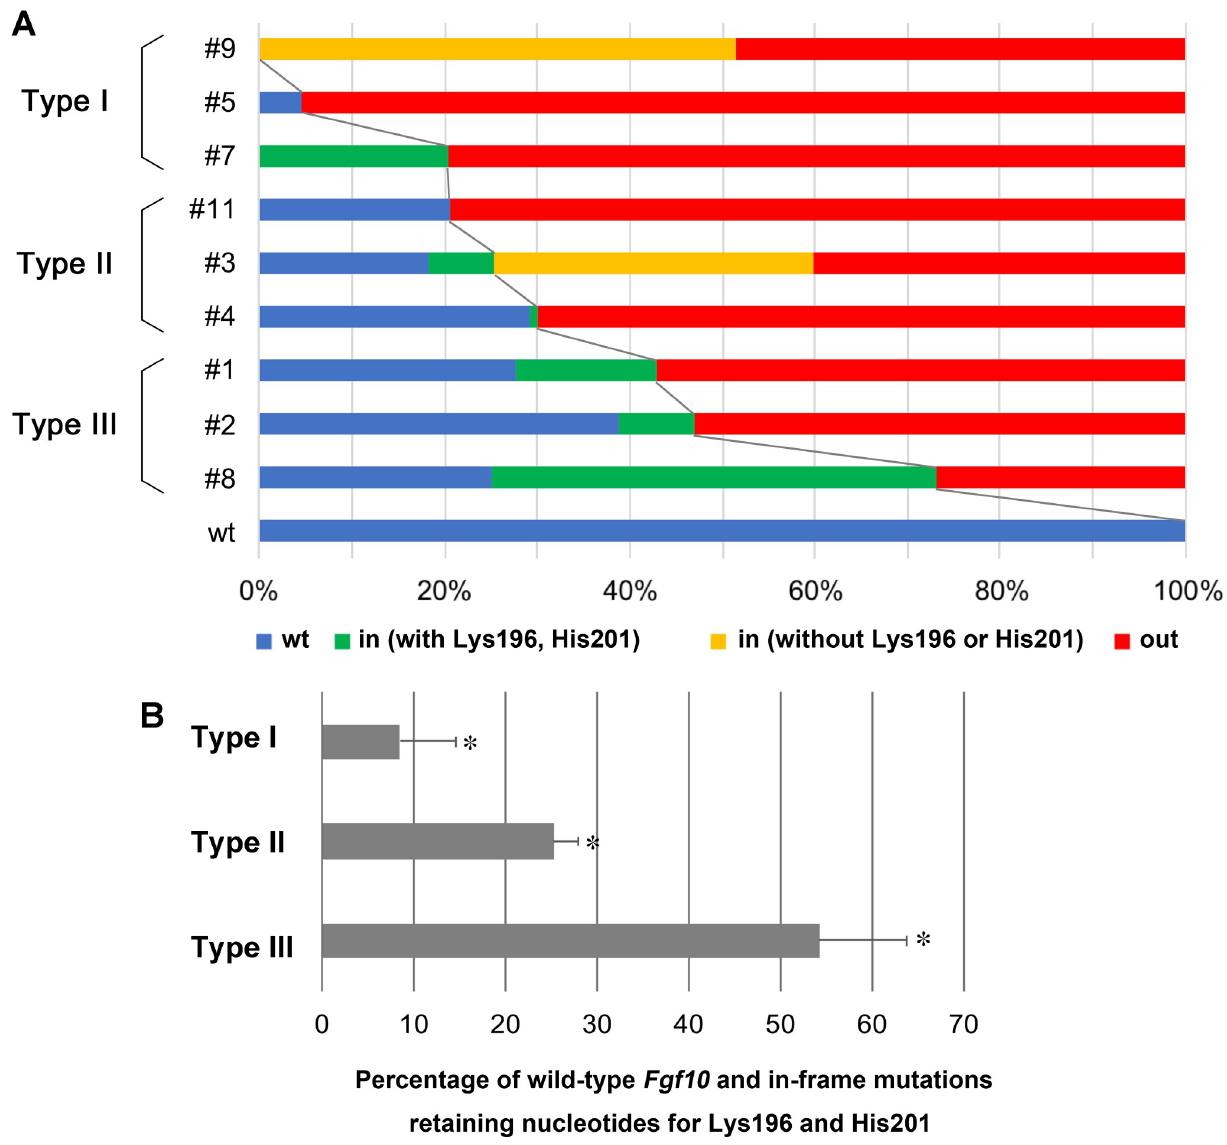
Fig 4. Schematic representation of genomic analysis of Fgf10 -CRISPR F0 embryos at E16.5 by deep sequencing. A , percentage of total reads for the Fgf10 crispants. wt, wild type Fgf10 target nucleotide sequence; in, in-frame mutations by small insertion or deletion; out, frameshift mutations. Among in-frame mutations, the percentage of those that preserve the codons for Lys196 and His201 is shown in green, while the percentage that eliminate either of them or both is shown in yellow. B , percentage of wild type and in-frame mutations in which nucleotides for both Lys196 and His201 are retained: 8.3 ± 6.2% for type I, 25.3 ± 2.7% for type II, and 54.3 ± 9.5% for type III. Data are presented as means ± SEM. � p < 0.01 ( p = 0.008).